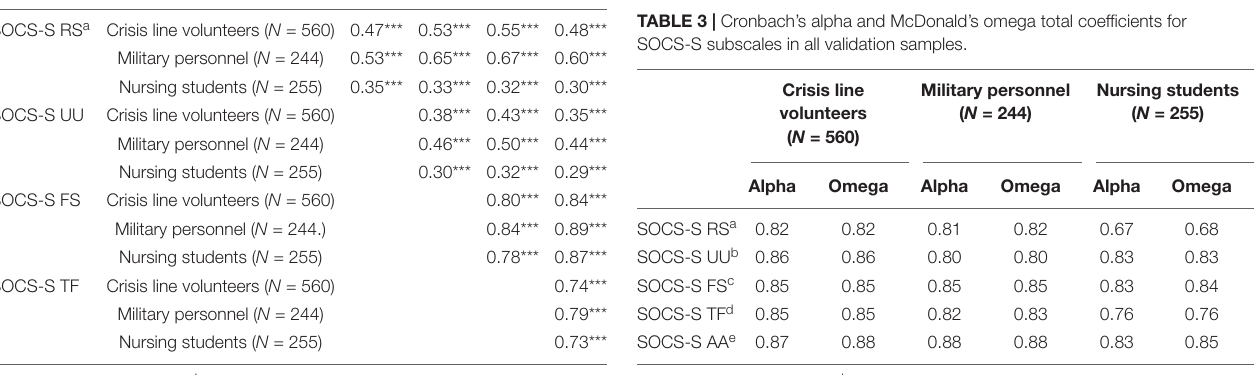
demonstrated to be significant but only weak to moderate in magnitude ( r = 0.18 to r = 0.48).